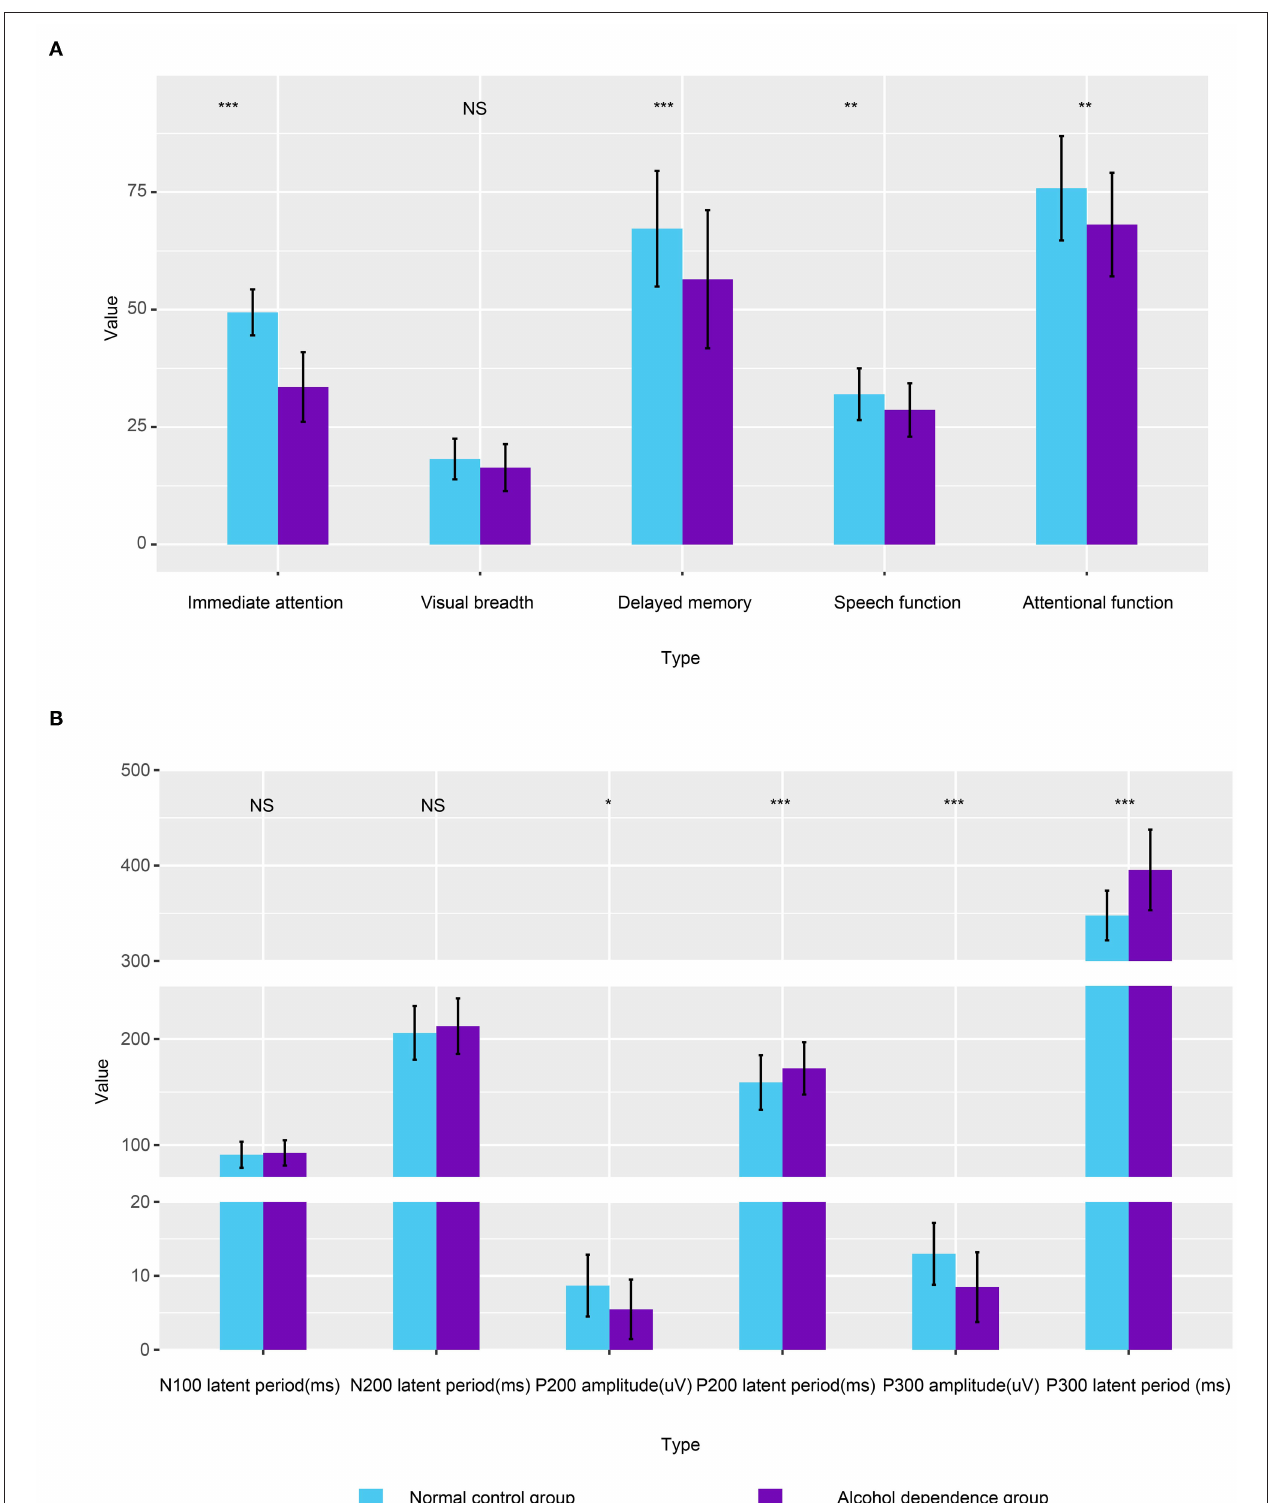
FIGURE 1 | Column plot depicting the differences of alcohol-dependence group and the normal control group. (A) The correlation between the first-drinking age, alcohol dependence years, daily alcohol consumption, and RBANS scores in the alcohol-dependence group. (B) Comparison of ERPs between the alcohol-dependence group and the normal control group. Error bars refer to the SEM of each variable.